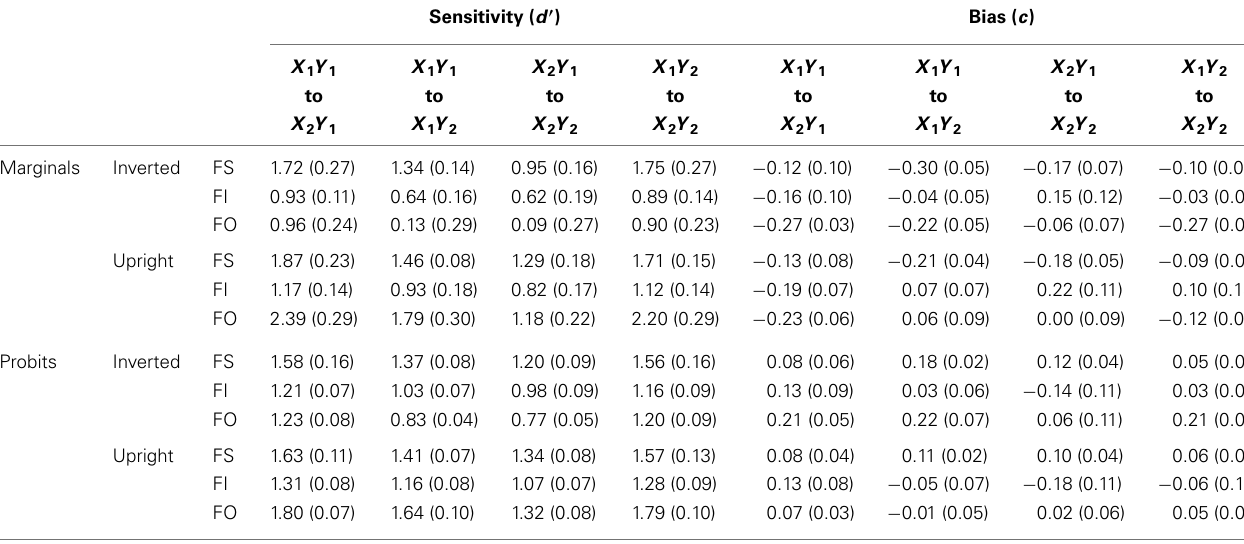
Table 3 | Sensitivity and bias values (and standard errors) for the marginal and probit